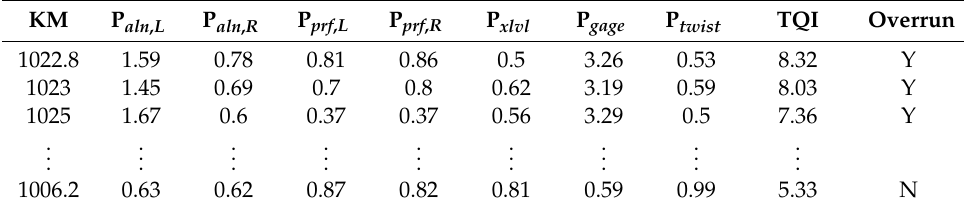
Table 2. Value of the TQI and geometric parameters (unit: